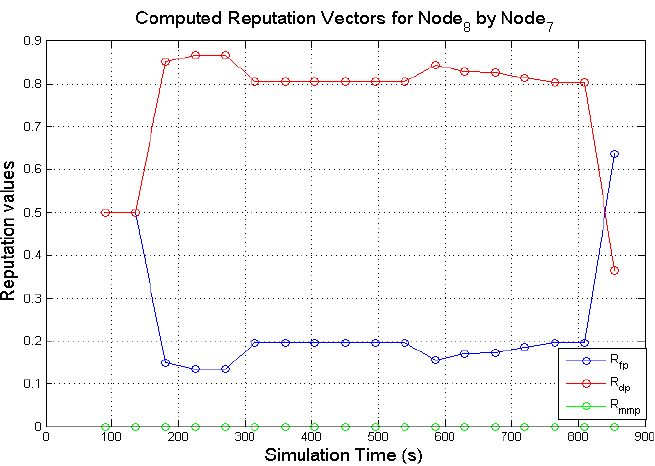
Figure 9. Reputation values for grey-hole node ( N 8 ) calculated by good node ( N 7 ).